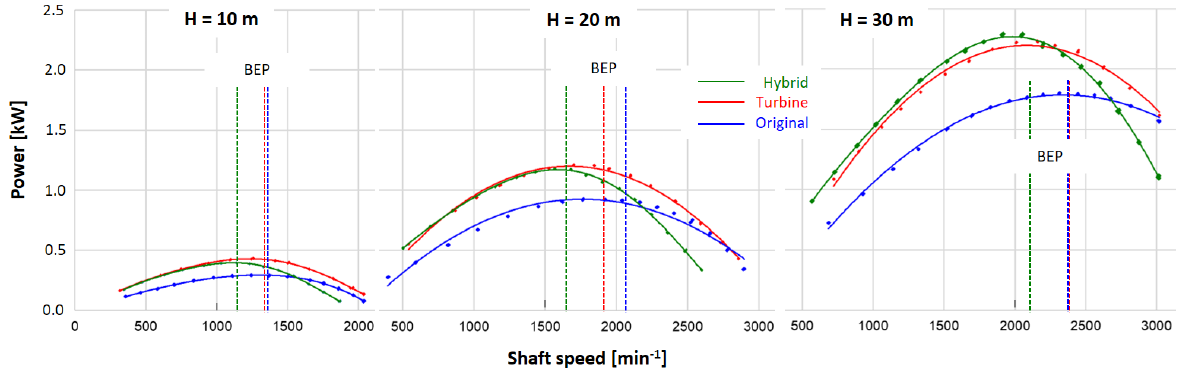
Figure 11. Courses of power output in terms of dependence on shaft